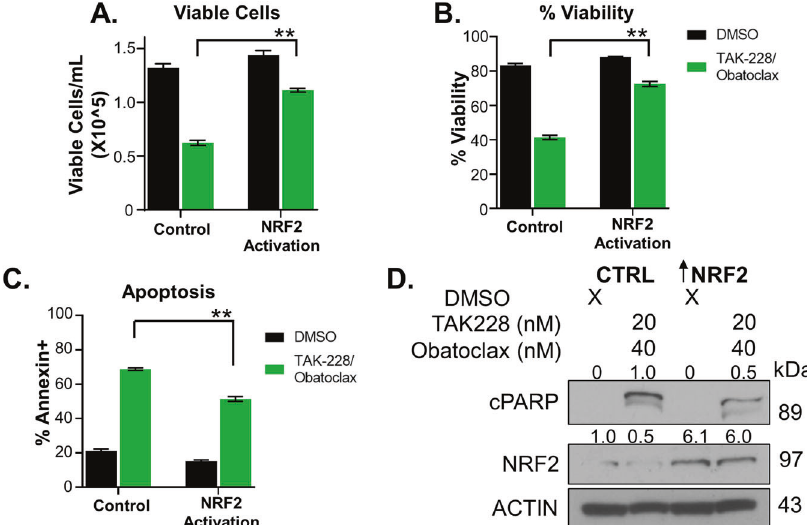
Fig. 5 NRF2 rescues the impact of combination therapy on AT/RT growth, viability, and apoptosis. Empty vector control cells and NRF2- activated cells were treated with DMSO or TAK-228 combined with Obatoclax, and were compared with A number of viable cells in culture at